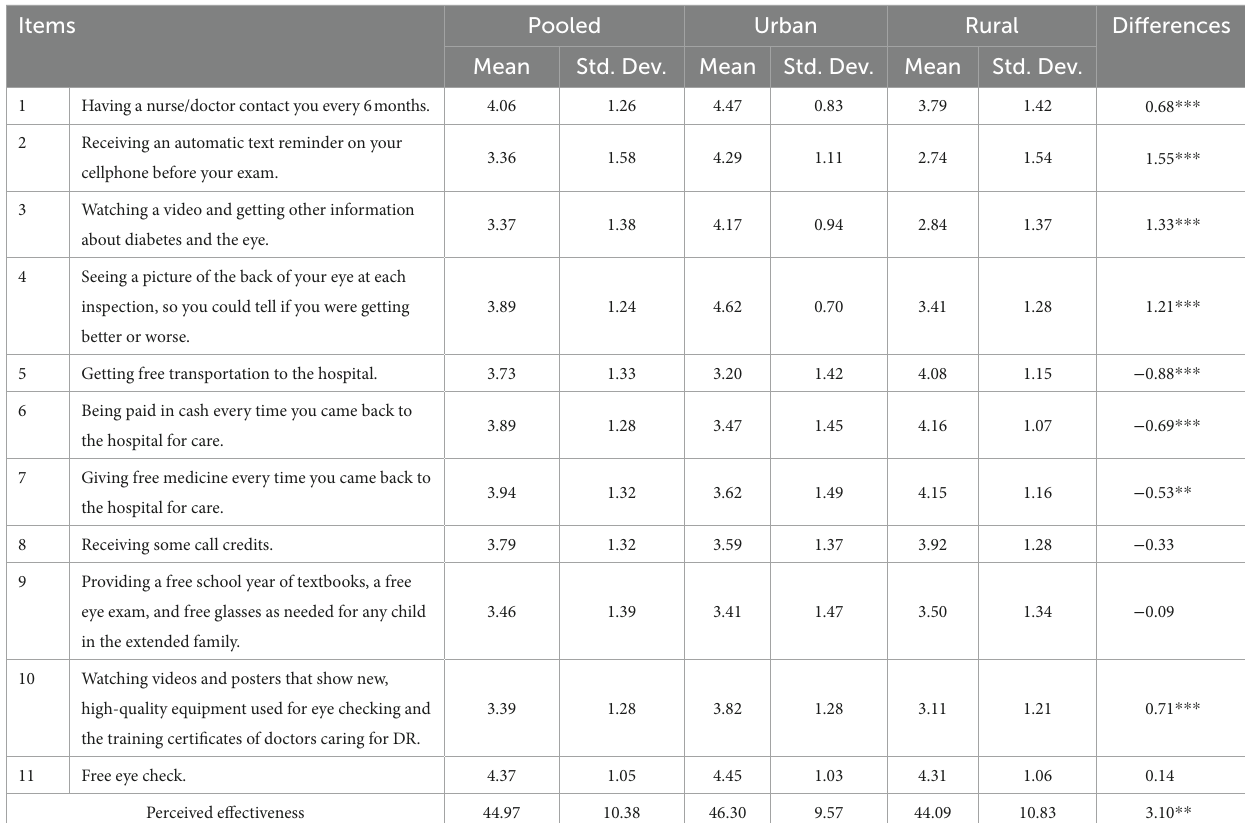
TABLE 2 Descriptive statistics of the perceived effectiveness of various incentive strategies. Items